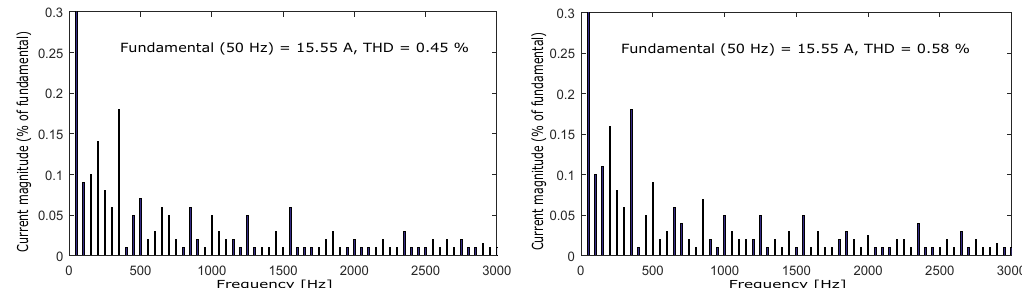
Figure 9. The dynamic response of the output voltage for the conventional FCS-MPC and proposed methods.